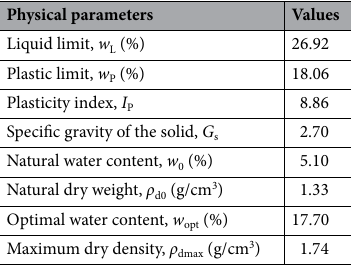
Table 1. Loess physical